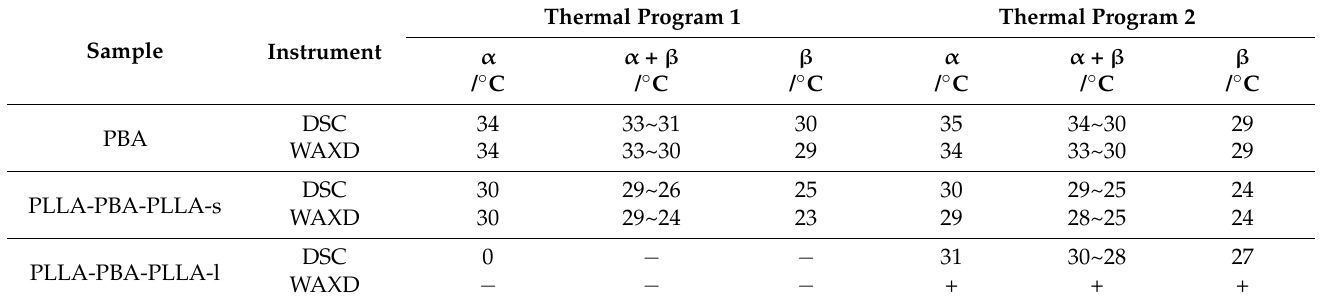
Table 2. Melt crystallization temperature of α , β , and α + β crystal forms of samples summarized from DSC and